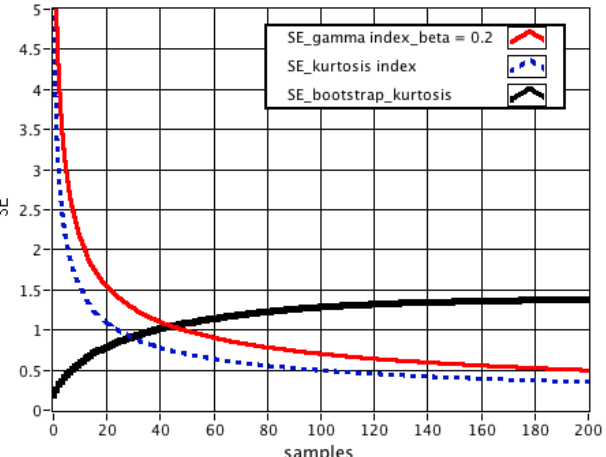
Figure 4: Comparison among SE evaluated by using the bootstrap method